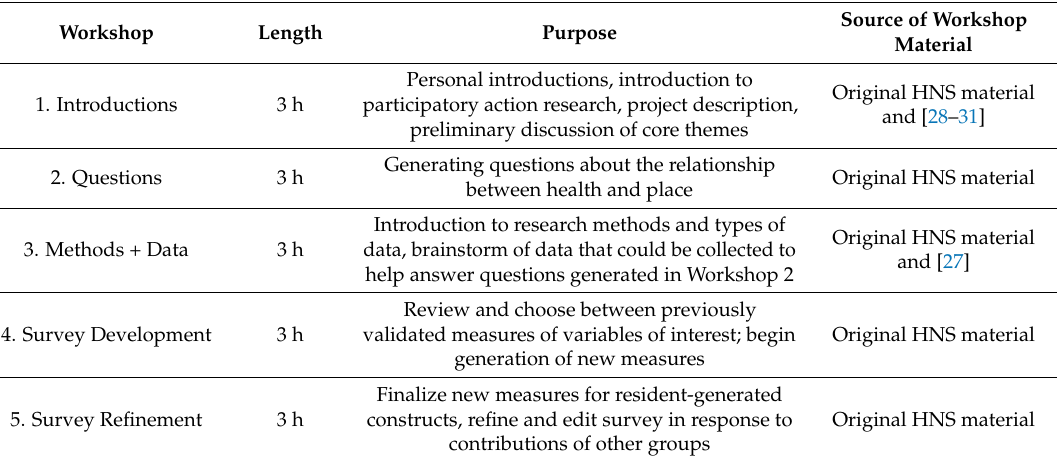
Table 2. Collaborative research design workshops,